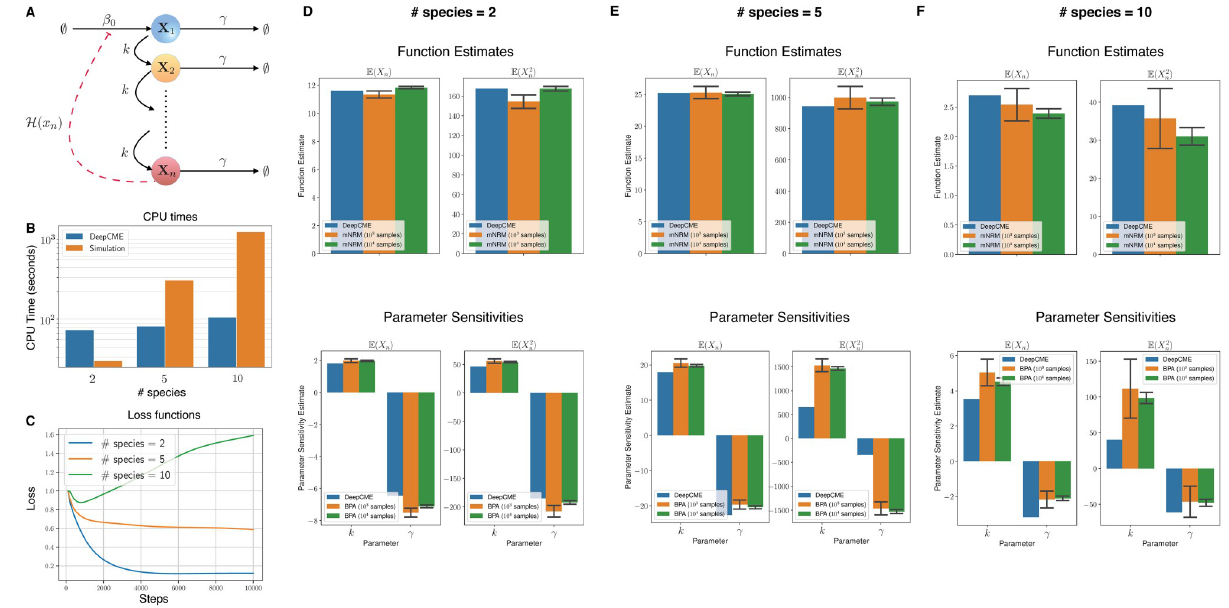
Fig 6. Linear signalling cascade with feedback. (A) Depicts the network with n species and 2 n reactions. The reaction shown with red dashed-arrow has propensity given by a nonlinear repressing Hill function (33). All other reactions have mass-action kinetics. (B) The CPU times are shown for DeepCME for different values of n (denoted as # species), and for comparison the time needed by simulation based methods (mNRM for function estimates and BPA for parameter sensitivities) with 1000 trajectories is also indicated. (C) Plots the validation loss function w.r.t. training steps for various n values. Panels (D-F) show estimates for the function values ( E ð X ð T ÞÞ and E ð X 2 ð T ÞÞ ) at T = 1 and the parameter sensitivities (only the n n significant sensitivities are shown). The estimates with simulation based methods are shown as 95% confidence intervals.